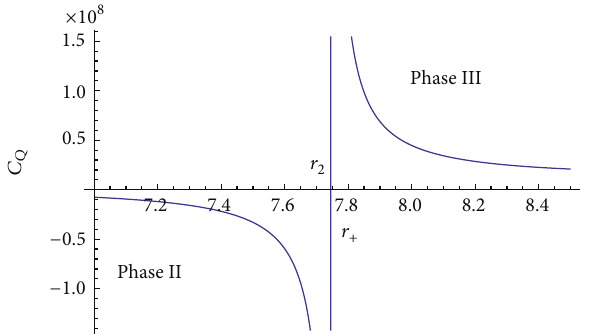
Figure 10: Plot of specific heat ( 𝐶 𝑄 ) against horizon radius ( 𝑟 + ), for 𝛼 󸀠 = 1.0 , 𝑄 = 0.05 , and 𝑏 = 0.05 at the critical point 𝑟 2 .